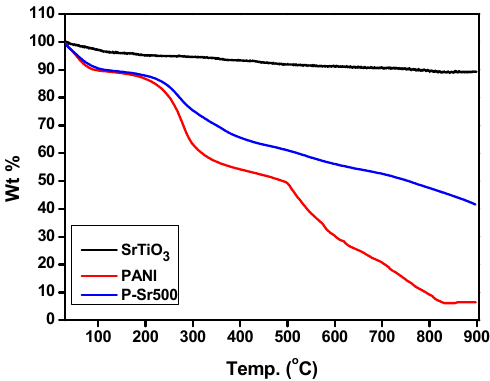
Figure 4. TGA thermogram analysis of PANI, SrTiO 3 and P-Sr500 nanocomposite.